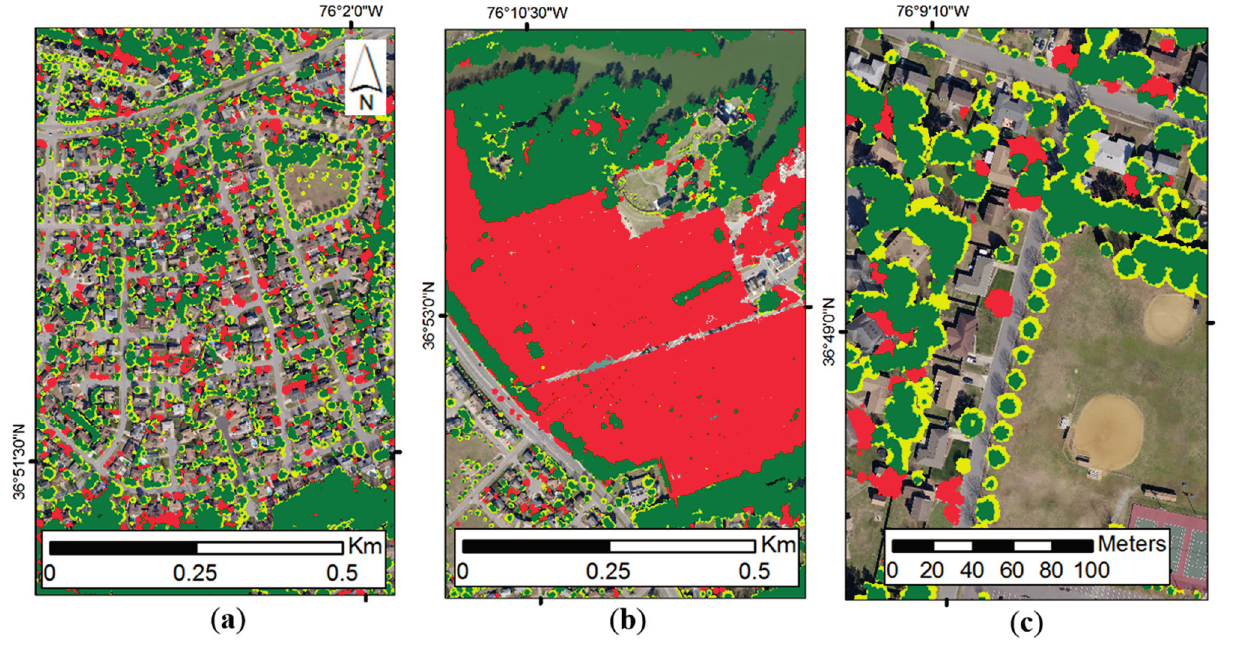
Figure 8. Retrospective change detection analysis for Virginia Beach, Virginia, USA based on automated comparison of GEOBIA-produced high-resolution tree canopy maps for two time periods, 2004 and 2012. ( a ) 2004–2012 change-detection layer with No Change (green), Loss (red), and Gain (yellow), superimposed on 0.152-m GSD 3-band orthoimagery. ( b ) Loss attributable to land cover conversion from forest to developed land uses. ( c ) Gain along margins of tree